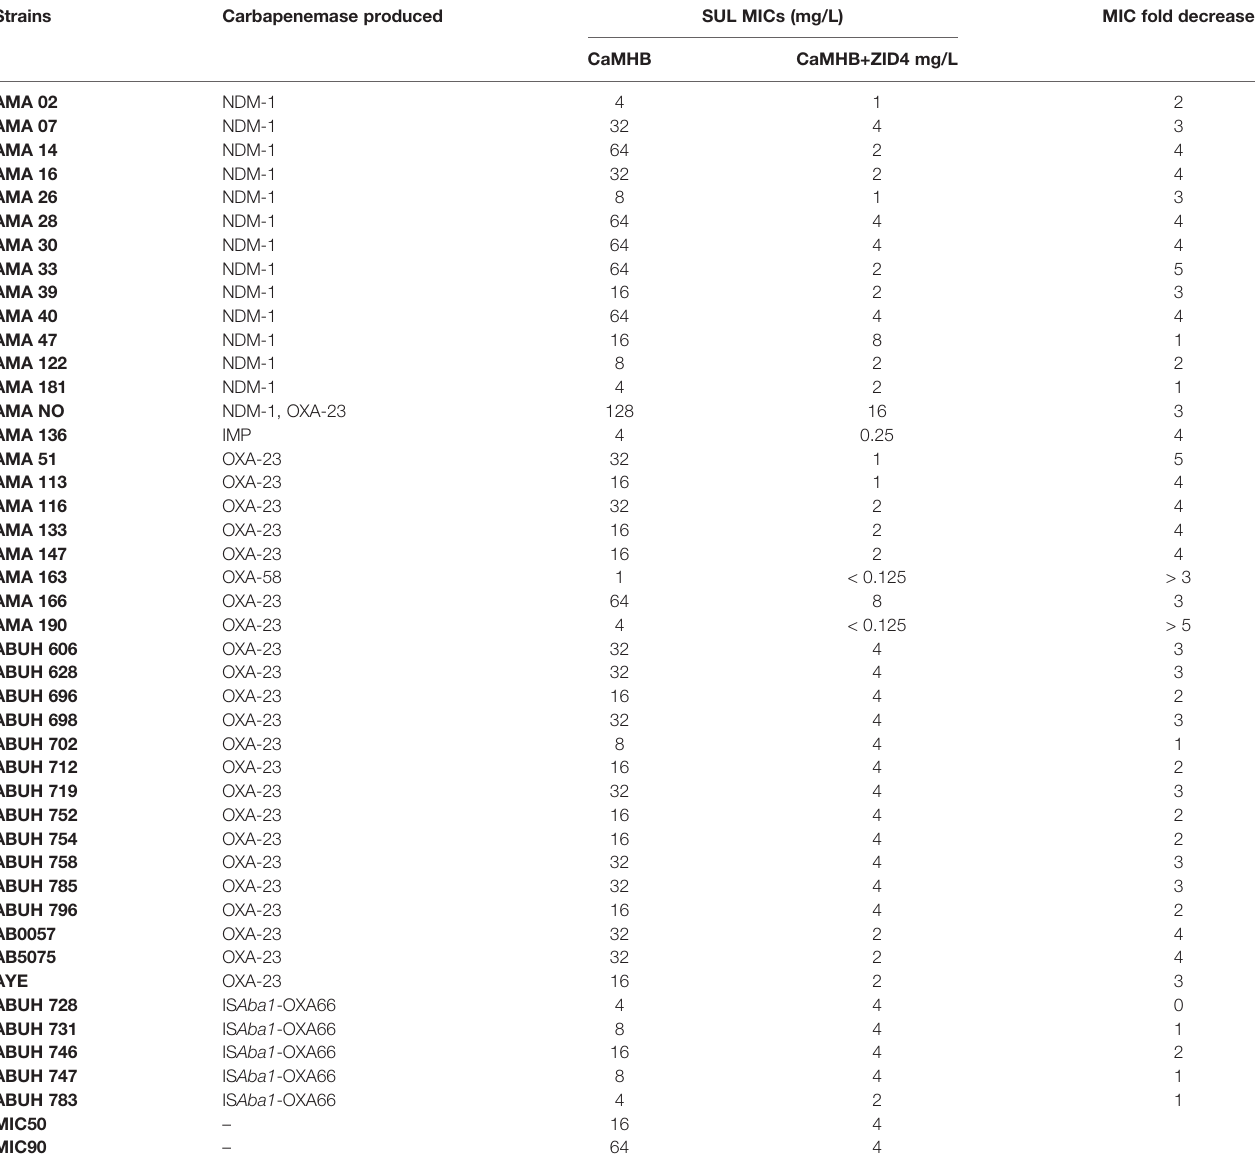
TABLE 1 | Sulbactam MICs against CRAB strains on cation-adjusted Mueller – Hinton broth with and without zidebactam supplementation. Strains Carbapenemase